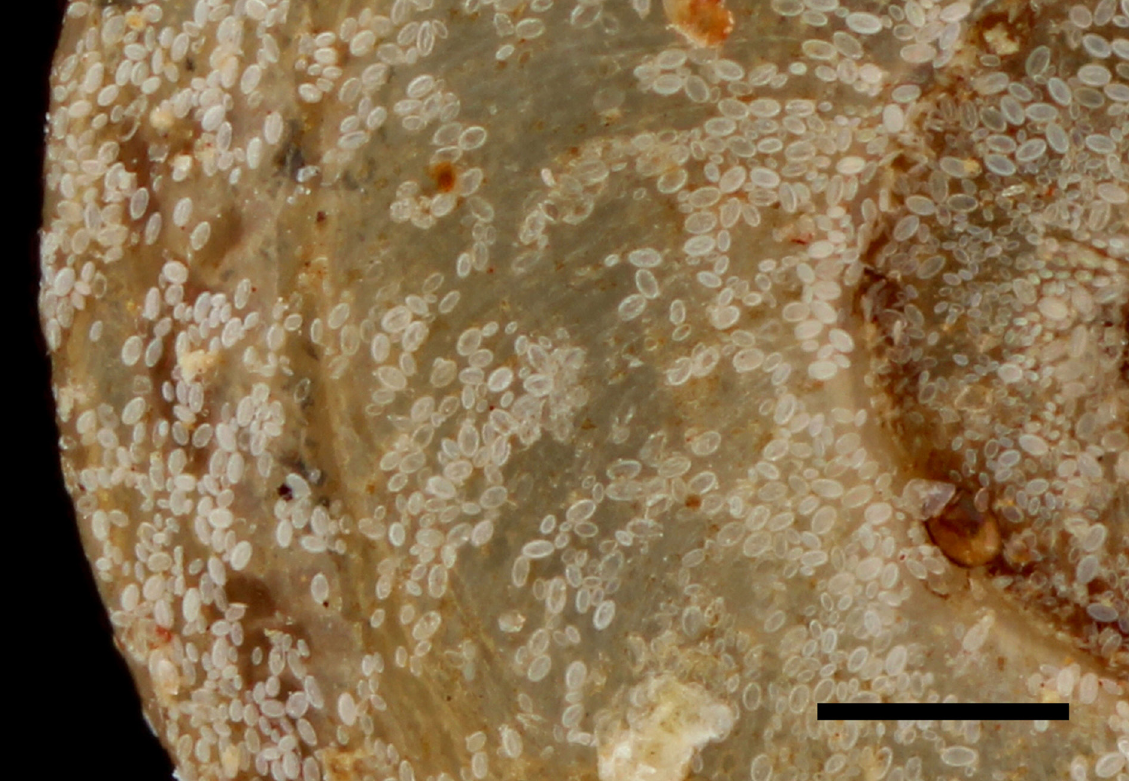
Fig. 2.7. Translucent specimen in detail. Close-up view of the outer surface of a specimen of Gyraulus costulates exilis . Scale = 500